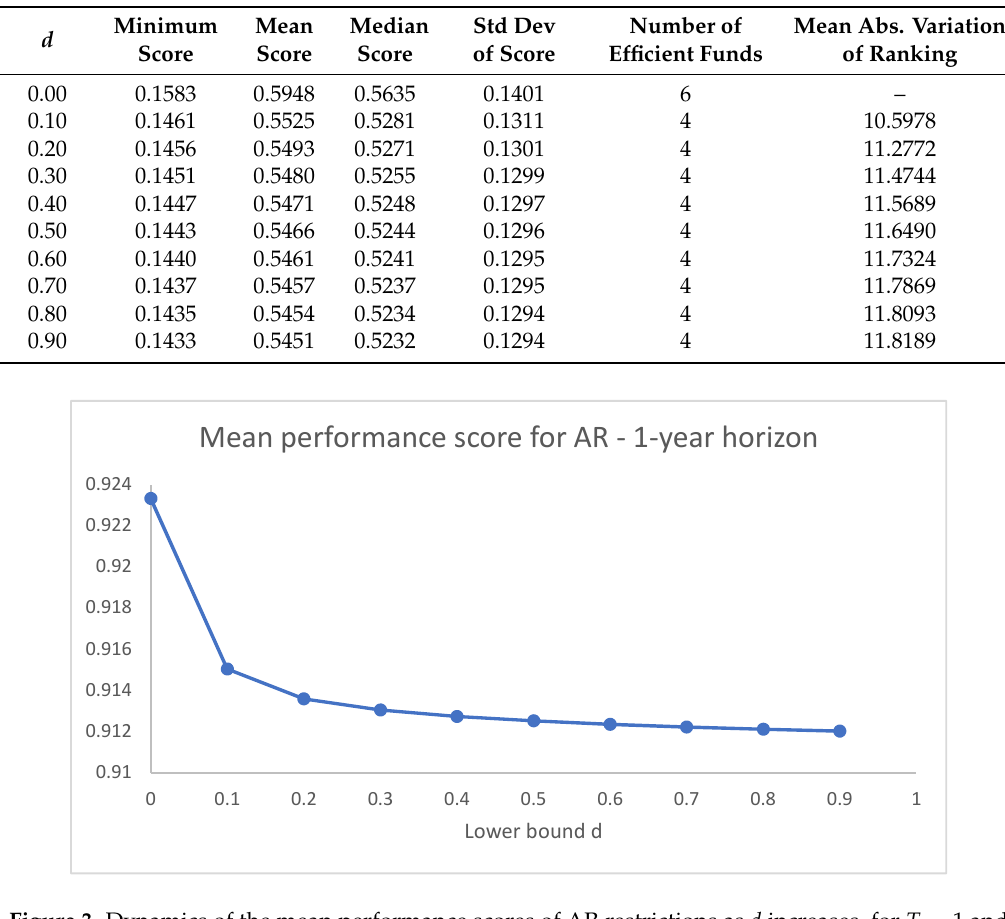
Figure 3. Dynamics of the mean performance scores of AR restrictions as d increases, for T = 1 and symmetric bounds.